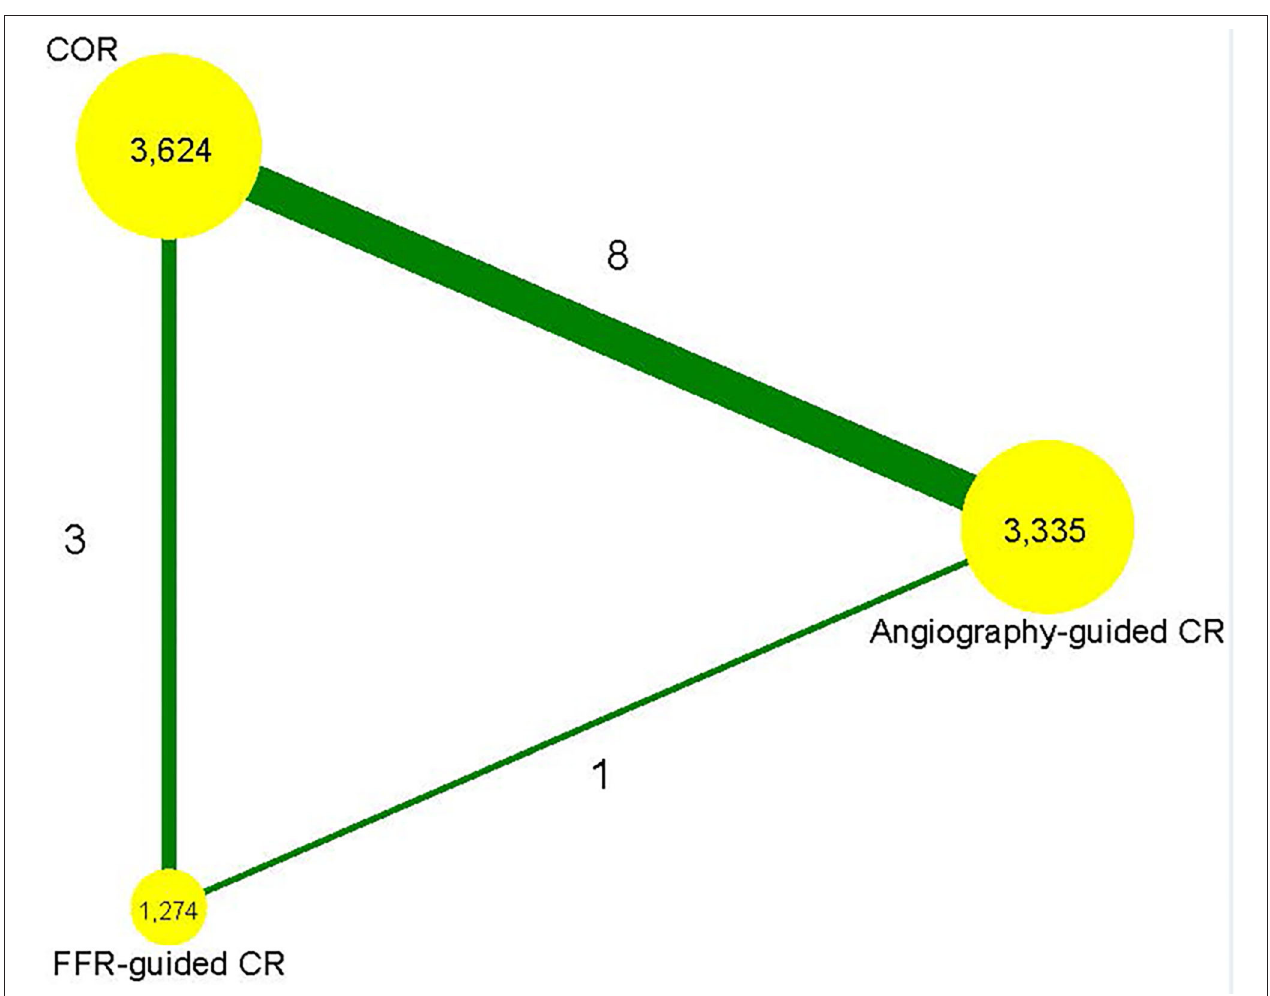
FIGURE 1 | Network plot. FFR, fractional flow reserve; CR, complete revascularization; COR, culprit-only revascularization.